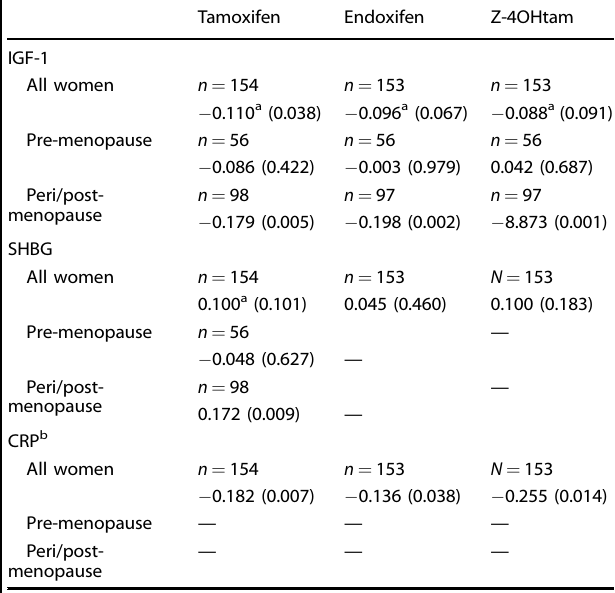
Table 1. Associations between tamoxifen and endoxifen and 4OH- tamoxifen concentrations and biomarker levels at 1